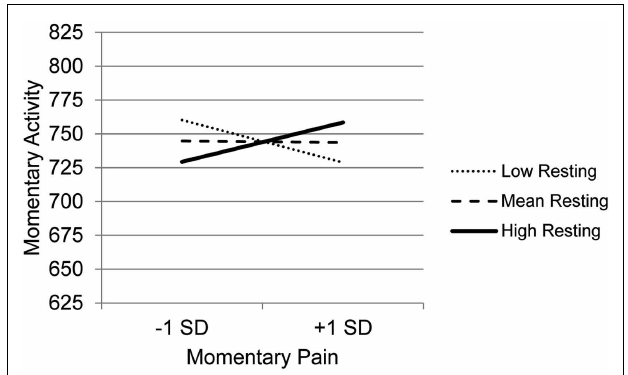
FIGURE 1 | Simple regression slopes for centered momentary pain and use of Resting at low, mean, and high levels of momentary physical activity.